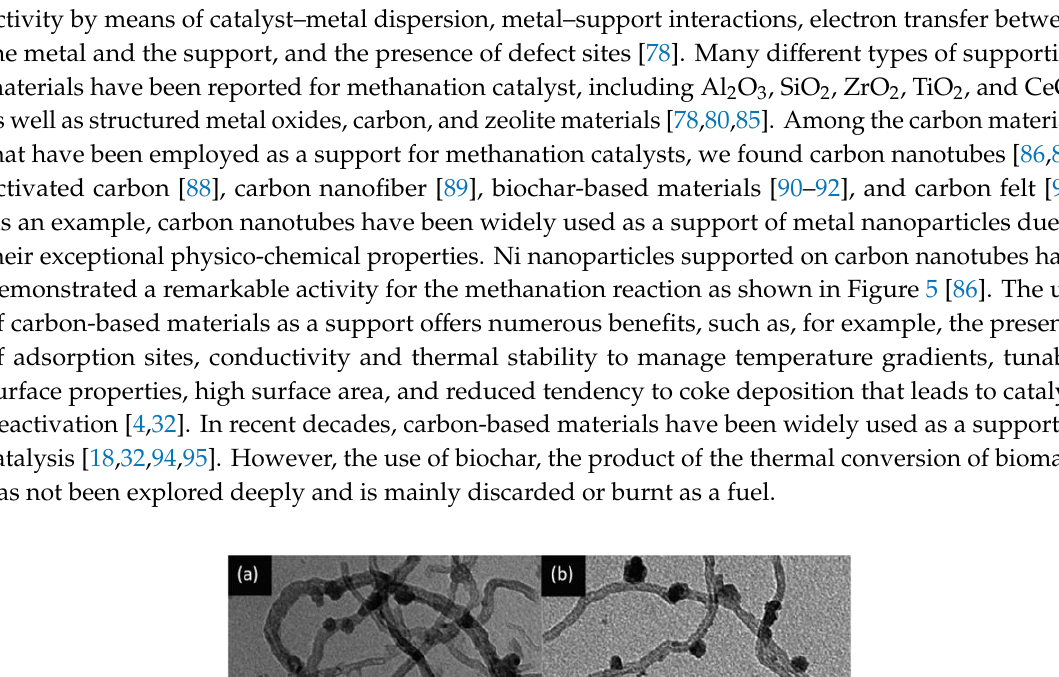
Figure 6. ( A ) TEM and HRTEM ( B ) images of the catalysts Ru/N-ABC pyrolyzed at 600 °C; the inset in part ( A ) displays the particle size distribution obtained by TEM. Temperature dependence of CO 2 methanation over the catalysts: ( C ) the CO 2 conversion; ( D ) the CH 4 and CO selectivity. Reproduced from [92] with permission from Elsevier 2020. 4. Conclusions and Future Perspectives Biomass has demonstrated that it serves as a promising raw material for the development of sustainable carbon-based materials and added value porous carbon materials. Its properties, especially the porosity of carbon materials, can be tailored by choosing the appropriate biomass feedstock and adjusting process parameters during carbonization and the activation process. This fact, together with the chemical stability, easy modification of the surface chemistry, possible metal modification, and low-cost and sustainability, make these materials very promising for their use as a